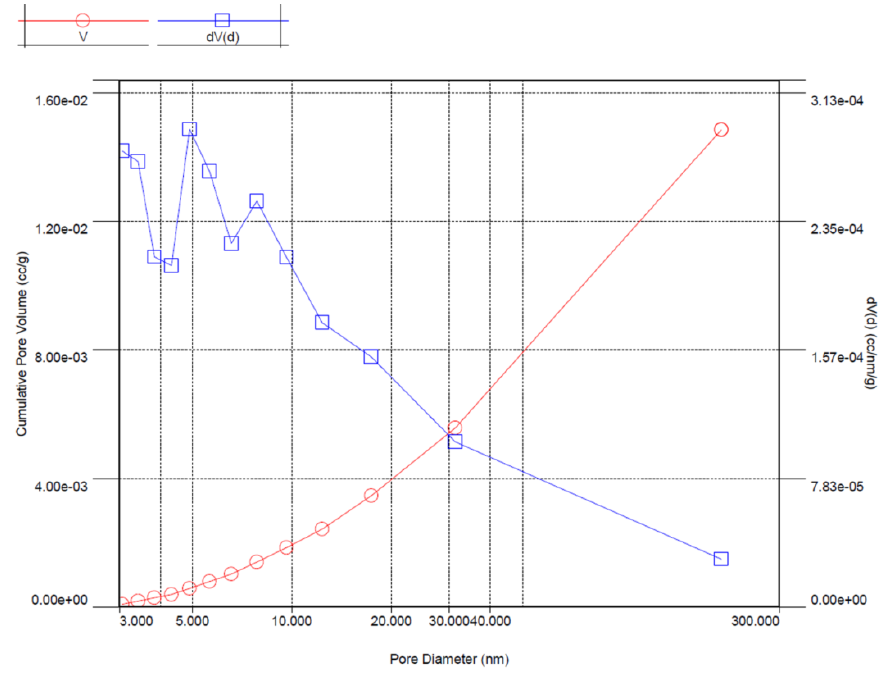
Figure 7. BJH–BET adsorption isotherms for F_45. Table 5. BET data for all CS fractions.